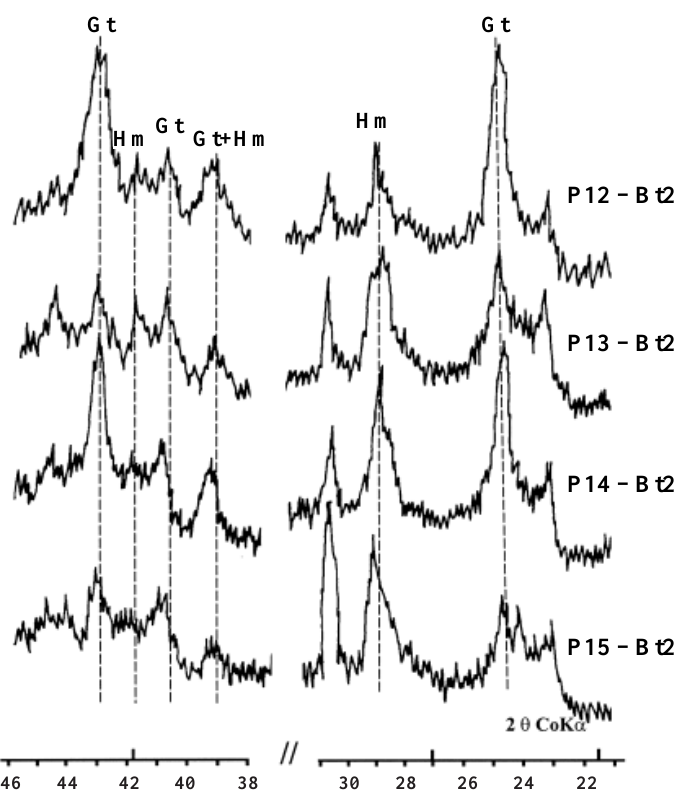
Figura 9. Difratogramas de raio-X da fração argila concentrada com NaOH 5M (não orientada) dos horizontes diagnósticos subsuperficiais dos perfis desenvolvidos de sedimentos coluviais (Hm: Hematita e Gt: